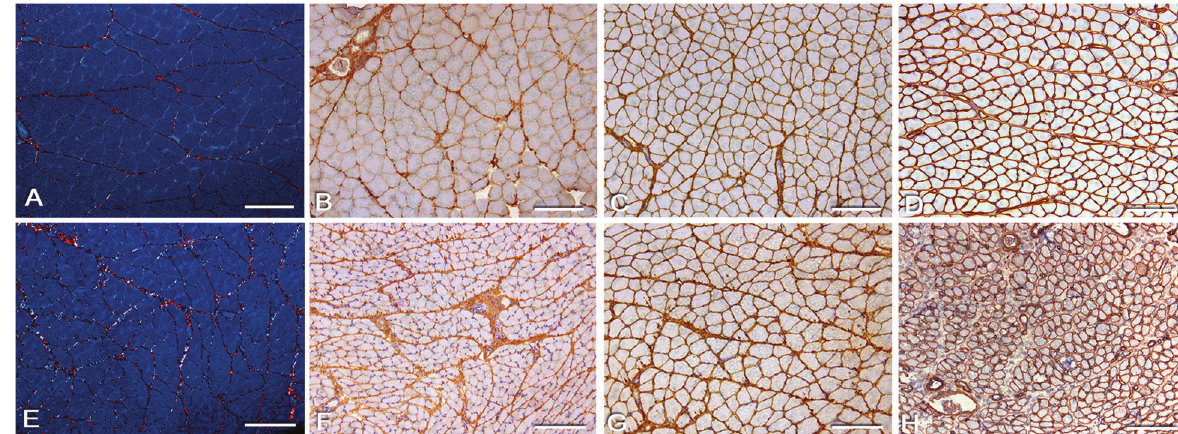
Figure 3. Photomicrographs of soleus muscle: labeling of connective tissue elements. Cross-sections of soleus muscle were stained with picrosirius red and immunolabeled for collagen types I, III, and IV. A and E : picrosirius red; B and F : collagen type I immunolabeling; C and G : collagen type III immunolabeling; D and H : collagen type IV immunolabeling. A (CG30) shows moderate to strong picrosirius red staining; E (ISG) shows strong picrosirius red staining; B (CG30) shows weak labeling for collagen type I; F (IG) shows moderate labeling for collagen type I; C (CG30) shows moderate labeling for collagen type III; G (SG) shows moderate to strong labeling for collagen type III; D (CG30) shows moderate to strong labeling for collagen type IV; H (ISG) shows moderate to strong labeling for collagen type IV. Bars: 50 m m. CG21: 21-day control group; CG30: 30-day control group; IG: immobilized group; ISG: immobilized and stretched group; SG: stretched group.